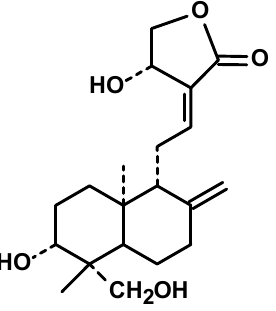
Figure 1. Chemical structure of andrographolide.